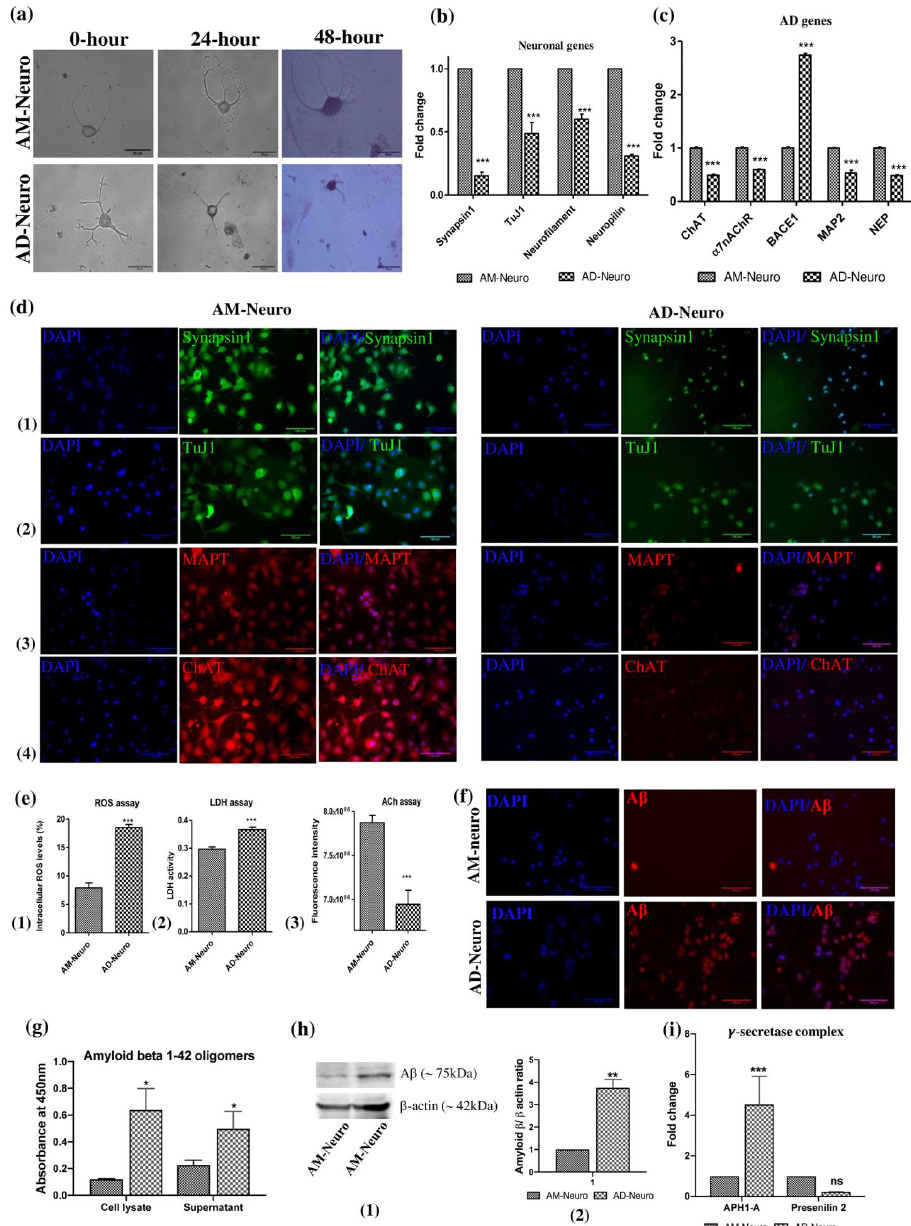
Figure 3. Induction of neurodegeneration was carried out using A β 1–42 . ( a ) Photomicrographs of cells undergoing degeneration on treatment with A β 1–42 (AM-Neuro and AD-Neuro cells stained with Giemsa, 40 × magnification, scalebar = 50 µ m). ( b ) Gene expression by qRT-PCR showing downregulation of neuronal genes synapsin1, tuj1, neurofilament and neuropilin. ( c ) qRT-PCR analysis for ChAT, α 7nAChR, BACE1, MAP2 and NEP. Data are represented as mean with SEM ( n = 3), * p < 0.05, ** p < 0.01, *** p < 0.001. ( d ) Immunofluorescence images of AM-Neuro (left) and AD-Neuro cells (right) showing expression of neuronal markers: ( 1 ) synapsin1, ( 2 ) tuj1, ( 3 ) MAPT and ( 4 ) ChAT (scale bar = 100 µ m). ( e ) Graphs representing increase in ( 1 ) intracellular ROS, ( 2 ) LDH activity and ( 3 ) decrease in ACh levels in terms of fluorescence intensity. Data are represented as mean with SEM ( n = 3), ** p < 0.01, *** p < 0.001. ( f ) Fluorescent images showing A β accumulation in AD-Neuro cells compared to AM-Neuro cells (scale bar = 100 µ m). ( g ) Graph showing A β levels ( h ) Western blot and corresponding densitometric analysis for A β levels with endogenous control, β -actin ( i ) PCR data showing upregulation of γ -secretase components- APH1-A and Presenilin 2 in AD-Neuro